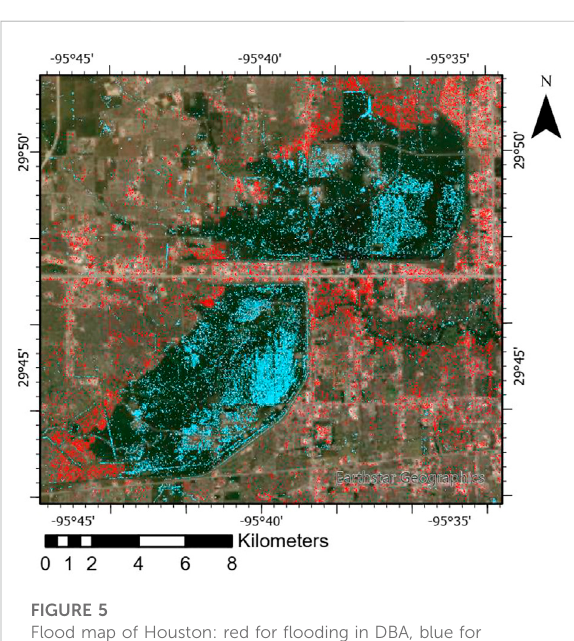
FIGURE 5 Flood map of Houston: red for fl ooding in DBA, blue for fl ooding in